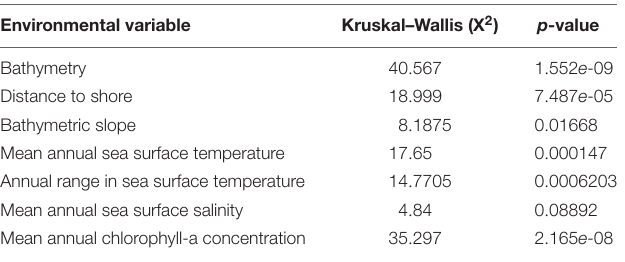
TABLE 5 | Results of the Kruskal–Wallis test for comparing environmental variables between Atlantic spotted dolphins, pantropical spotted dolphins and spinner